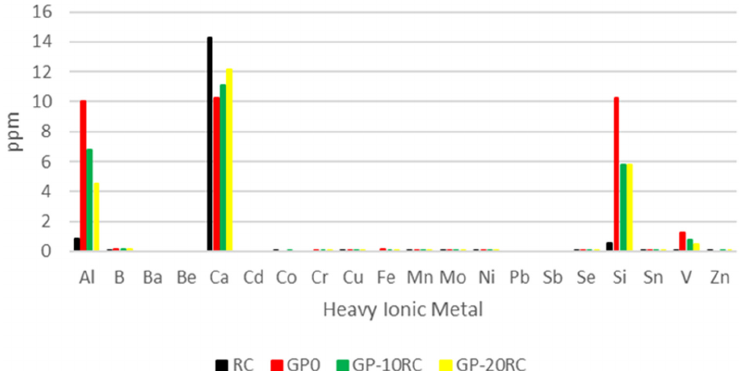
Figure 3. Results of the leaching test of the recycled corundum and the geopolymers samples. All the samples were diluted 1:10 and 1:20 to obtain the Al release. All the other heavy metals are detected without any dilution of the leachates.